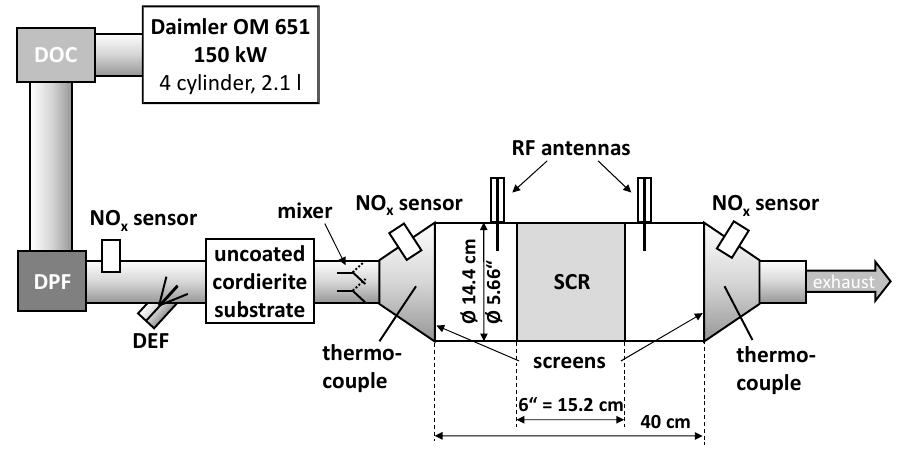
Figure 1. Illustration of the dynamometer setup: 2.1 ltr diesel engine with diesel oxidation catalyst and particulate filter, DEF dosing with uncoated cordierite substrate and plate mixer, Ø 5.66” (Ø 14.2 cm) selective catalytic reduction (SCR) catalyst canning defined by metal screens with two radio-frequency (RF) antennas, thermocouples up- and downstream of the SCR and three NO x sensors up- and downstream of SCR and upstream of DEF dosing, from [20].